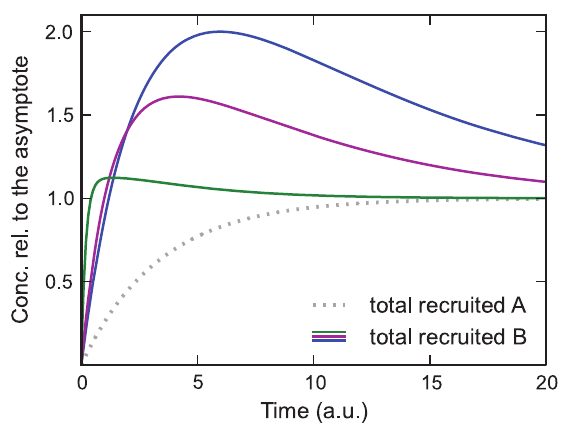
Figure 4. Model in which A decreases the association rate of B and in which dissociation is relevant. k (cid:3) ~ 5,0 : 5,0 : 1 from green to blue curve; k (cid:3) k (cid:3) S z B k SB { B ~ 0 : 1 . The curves are normalized to their asymptotic value at t ~ ? . In contrast to the previous models, the recruitment curves of this model have a maximum that is larger than the plateau value if